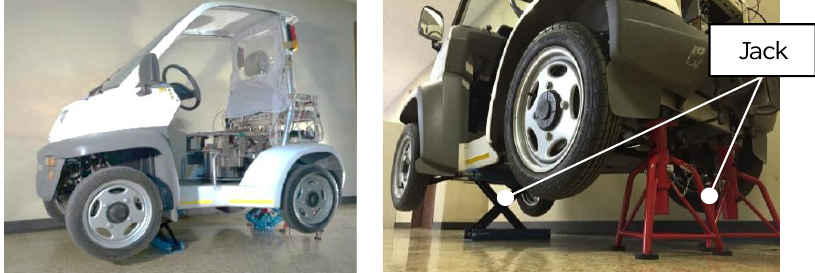
Figure 6. Photograph of the ultra-compact vehicle.